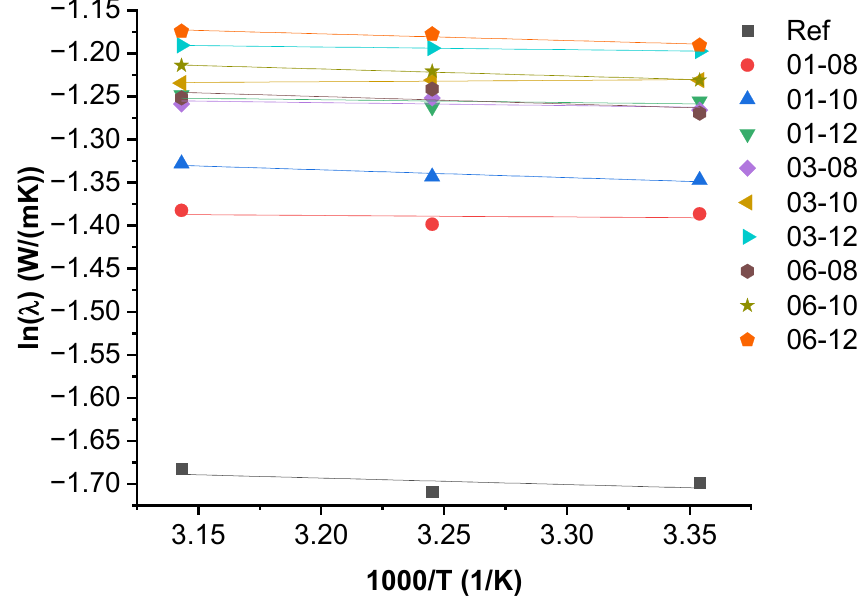
Figure 3. Arrhenius plots of PBS hybrid composites.